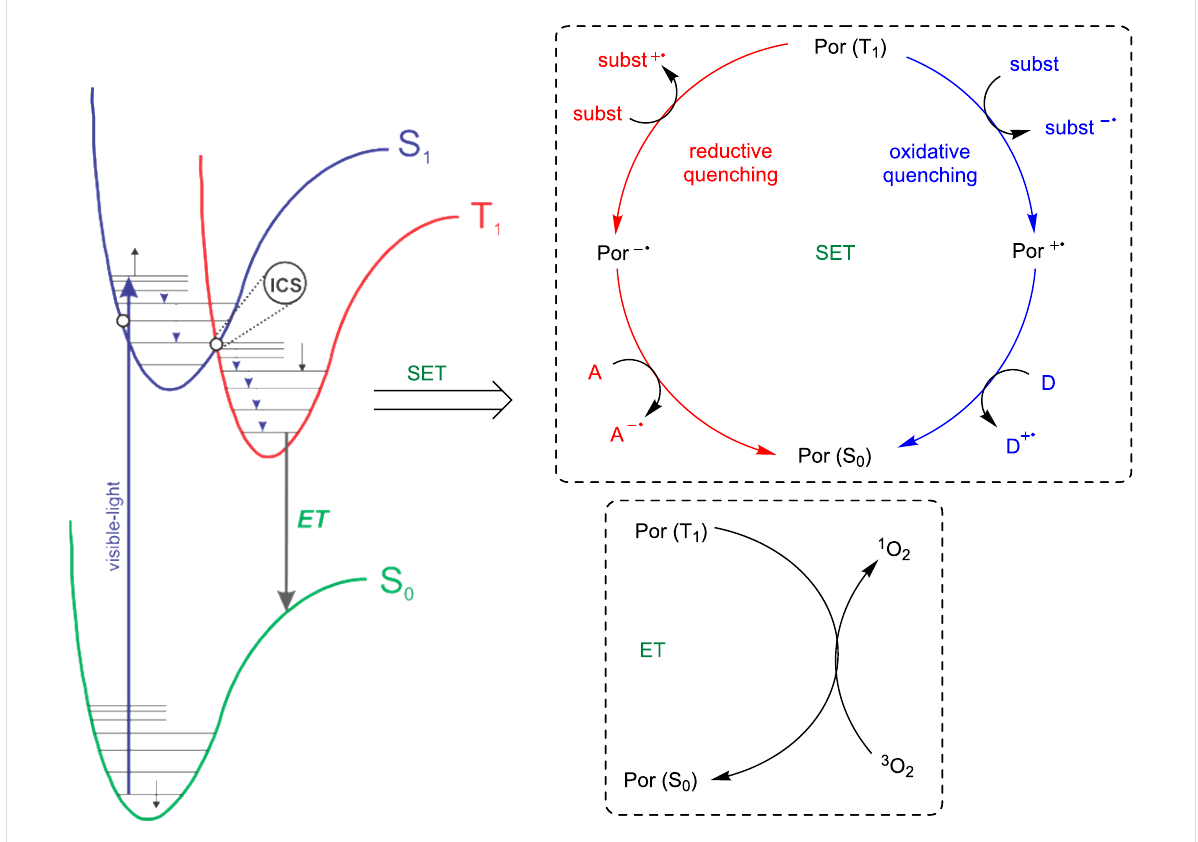
Figure 2: Photophysical and photochemical processes (Por = porphyrin). Adapted from [12,18].